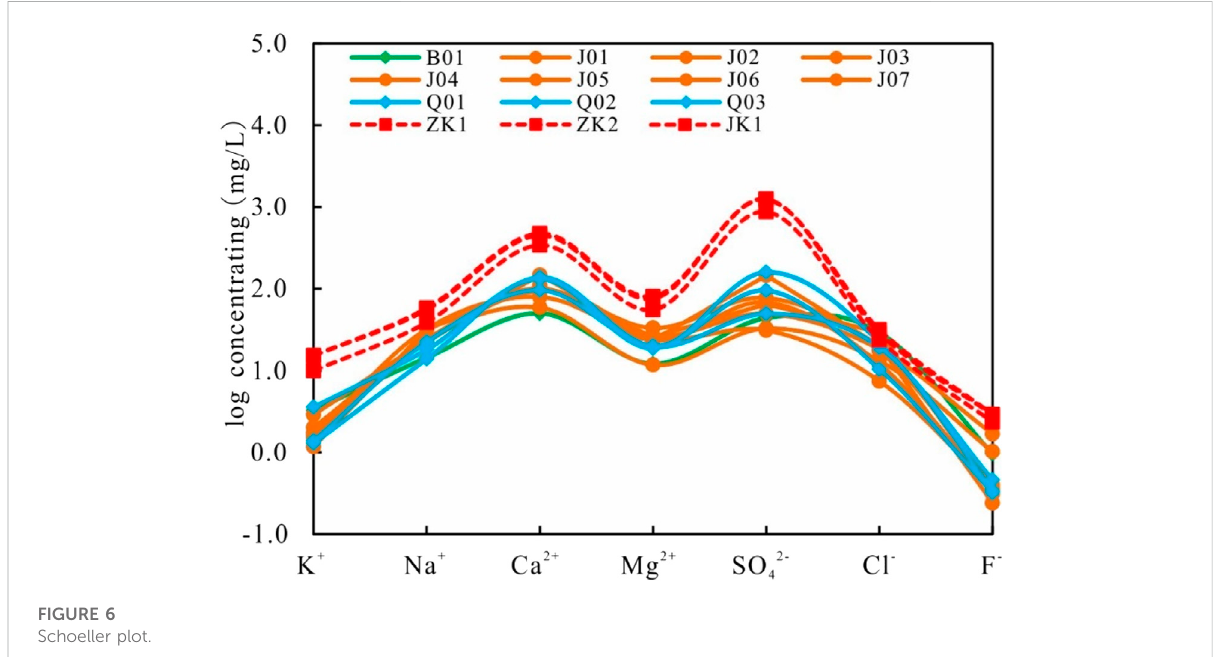
FIGURE 6 Schoeller